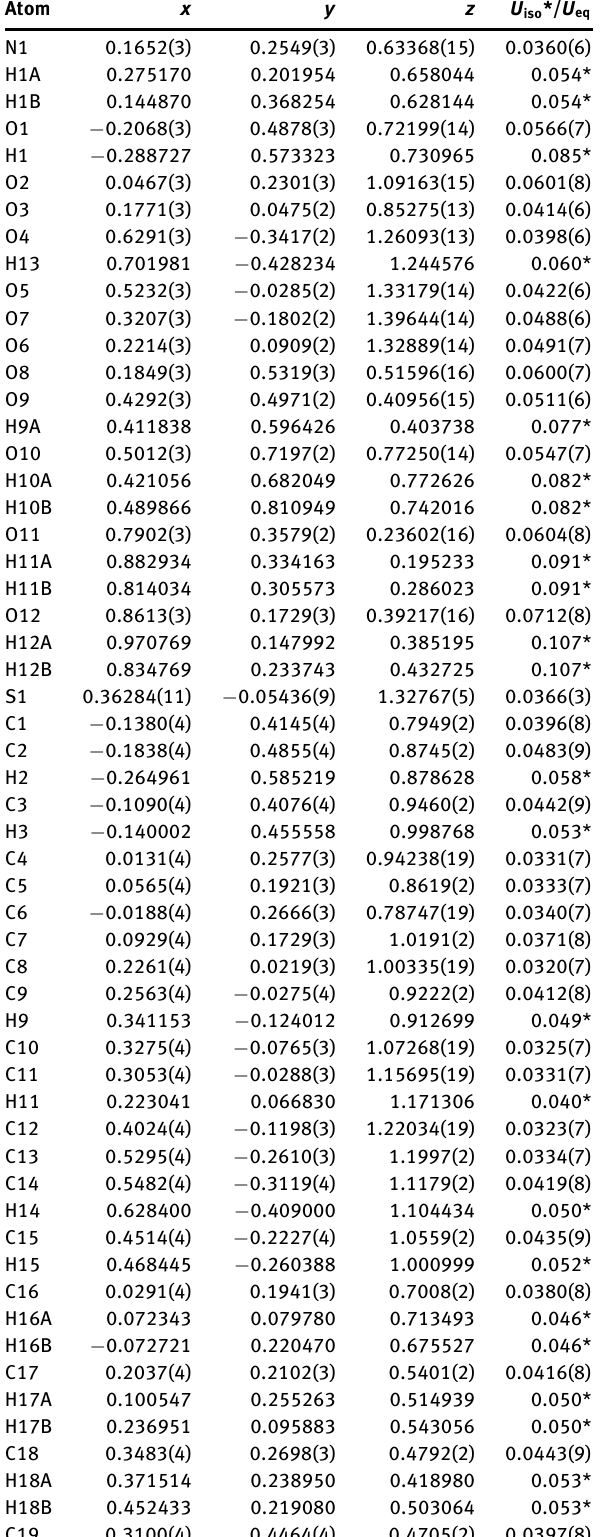
Table 2: Fractional atomic coordinates and isotropic or equivalent isotropic displacement parameters (Å 2